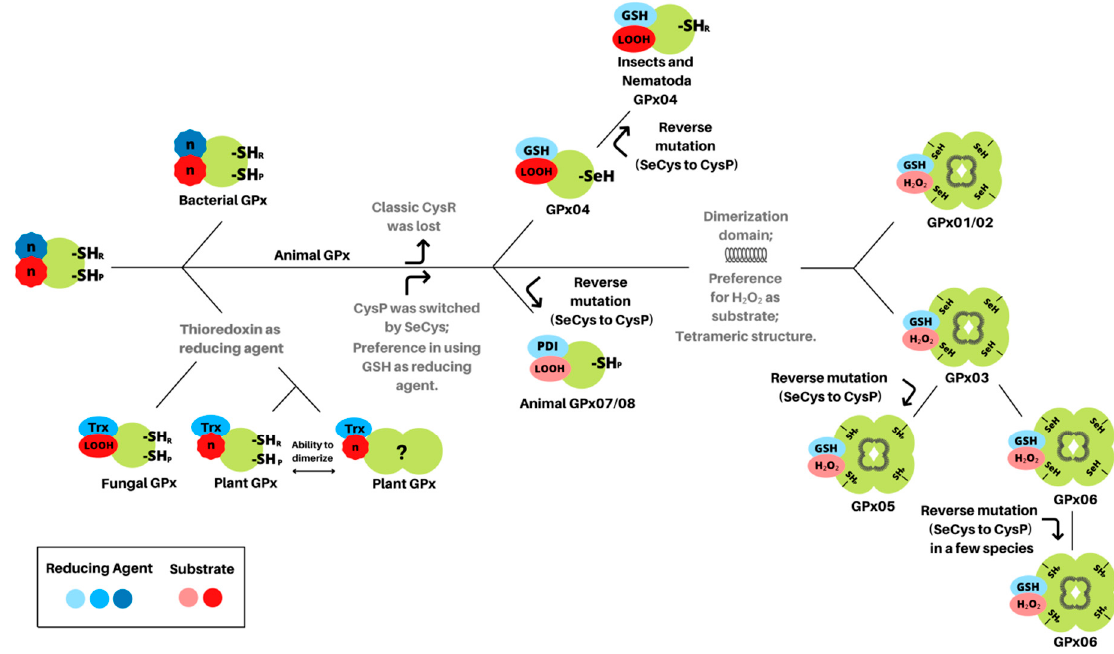
Figure 4. Diversification of glutathione peroxidases. The ancestral GPx protein was a promiscuous enzyme, regarding its substrate and reducing agent, and it contained a peroxidatic (SH P ) and resolving cysteines (SH R ). Throughout evolution, it has independently evolved to use specific substrates and reducing agents. Further information is described within the “Discussion” section. Reducing agents and substrates displayed indicate preferences, not necessarily exclusivity. GSH: reduced glutathione; Trx: thioredoxin; PDI: protein disulfide isomerase; n: several substrates/reducing agents; LOOH: lipid peroxides; H 2 O 2 : hydrogen peroxide; SeH and SeCys: selenocysteine; CysR: resolving cysteine; CysP: peroxidatic cysteine.